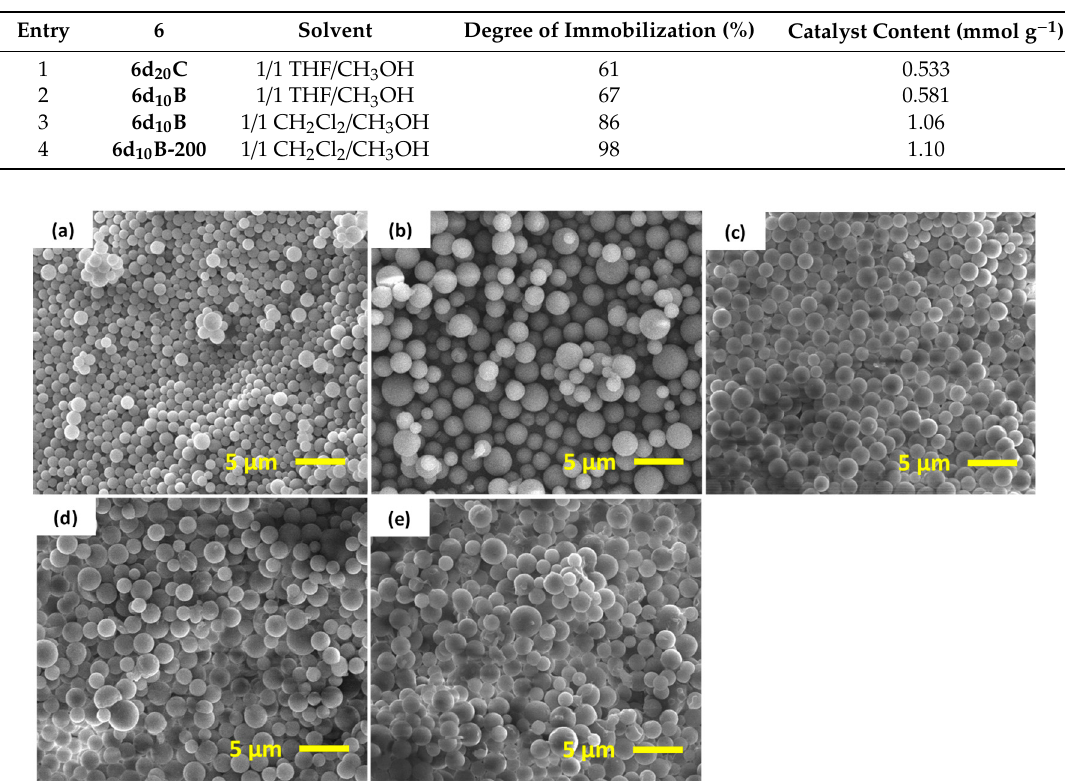
Table 2. Characterization of ICCC 6 .